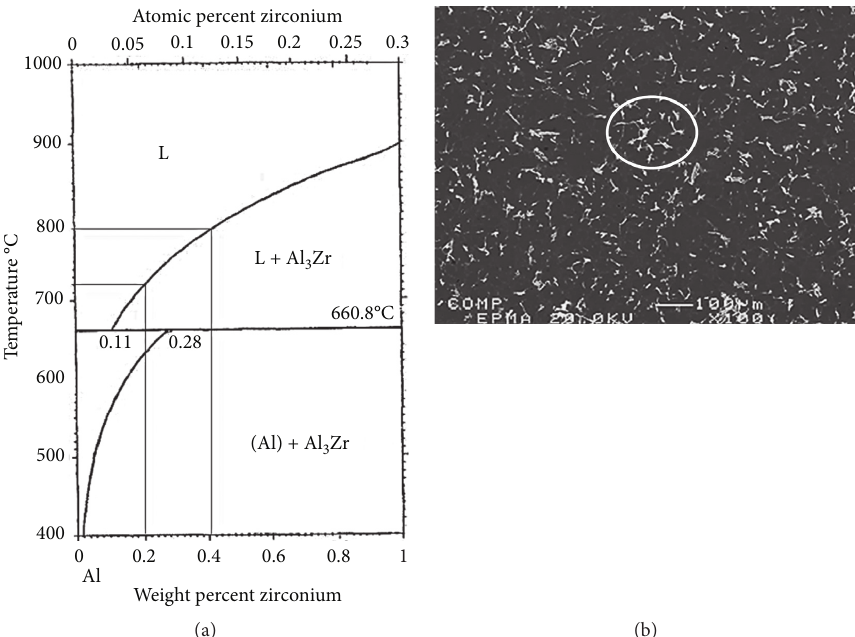
Figure 5: (a) Al-rich corner of Al-Zr binary phase diagram [33] showing the percentages of Zr used in the present study and (b) backscattered electron micrograph of alloy D solidified at the rate of ∼ 0.35 °